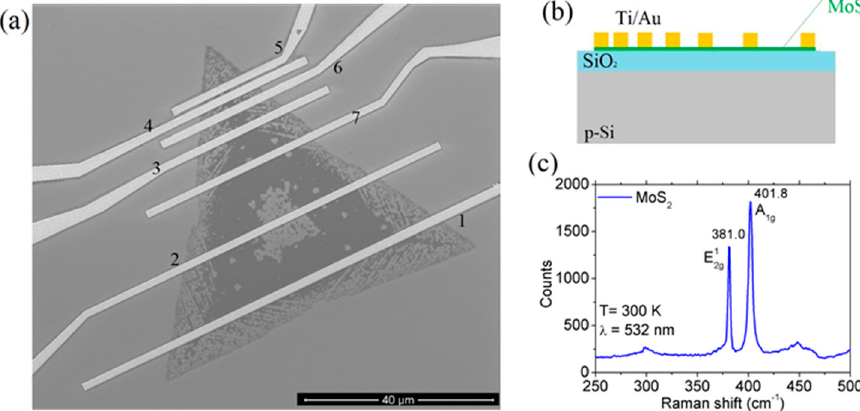
Figure 1. ( a ) SEM image of a Ti/Au contacted MoS 2 flake; ( b ) Schematic cross section of the field-effect device; ( c ) Raman spectrum of the flake.